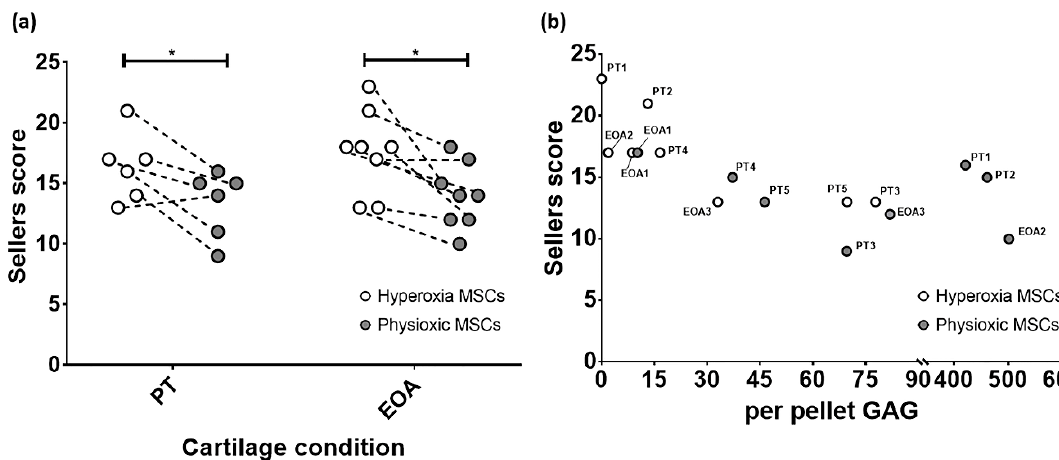
Figure 11. ( a ) Dot plot describing paired comparison between physioxia and hyperoxic MSCs treatment in post-trauma (PT) and focal early OA (EOA) models (* p < 0.05). ( b ) A dot plot depicting the relationship between per pellet GAG and subsequent Sellers score outcome for the treated defect. PT signifies post trauma model and EOA represents focal early OA model with respective animal number given.